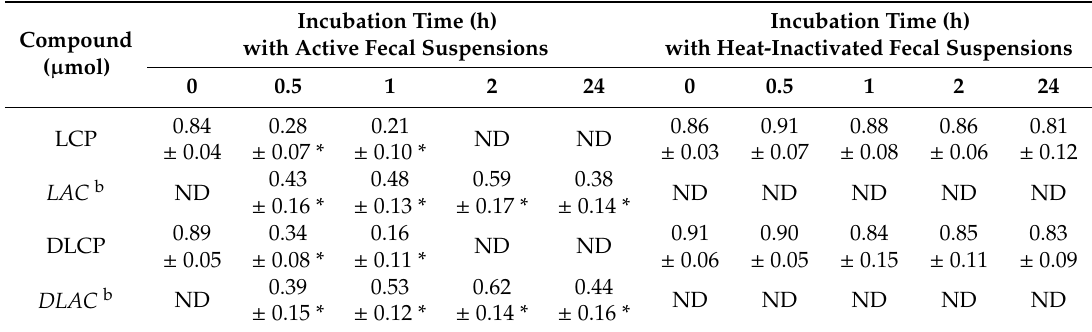
Table 3. Mean content of sesquiterpene lactones detected in active or heat-inactivated fecal suspensions incubated with lactucopicrin or 11 β ,13-dihydrolactucopicrin a .